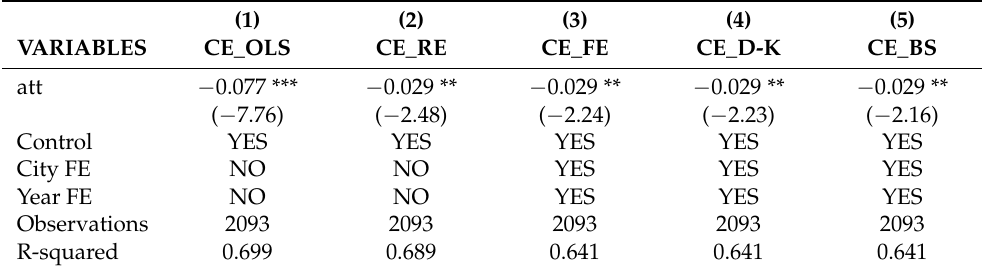
Table 2. Estimation results of the benchmark regression for